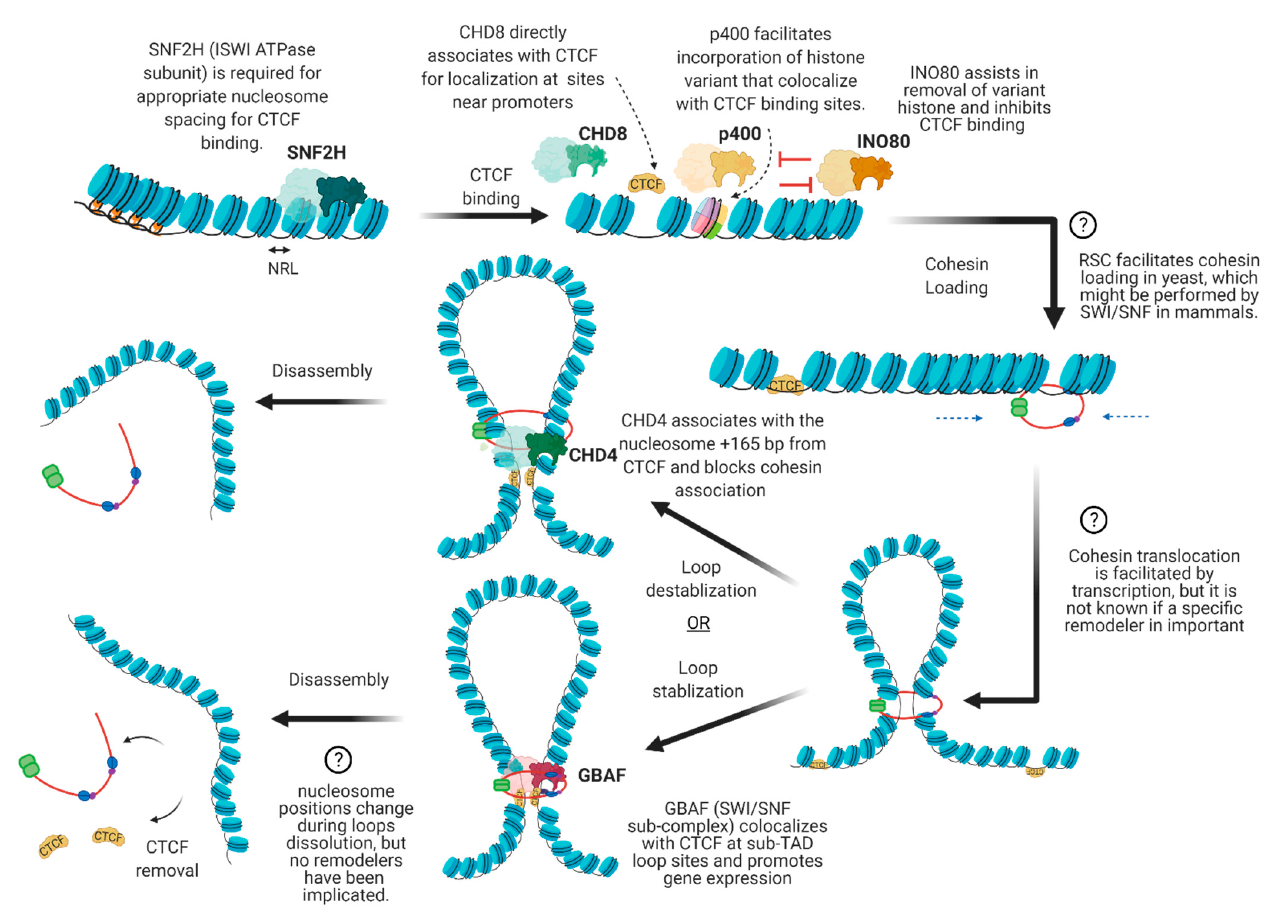
Figure 5. Speculative model illustrating potential roles for remodelers in the establishment of CTCF/cohesin mediated interactions. While the role for SNF2H in nucleosome spacing and CTCF binding is well established, the mechanism by which other remodelers regulate CTCF or cohesin is more speculative. Potential roles based on knowledge of biochemical mechanisms have been proposed, although the chromatin remodeling events may not necessarily involve the modes of chromatin remodeling presented (spacing, variant incorporation, eviction,